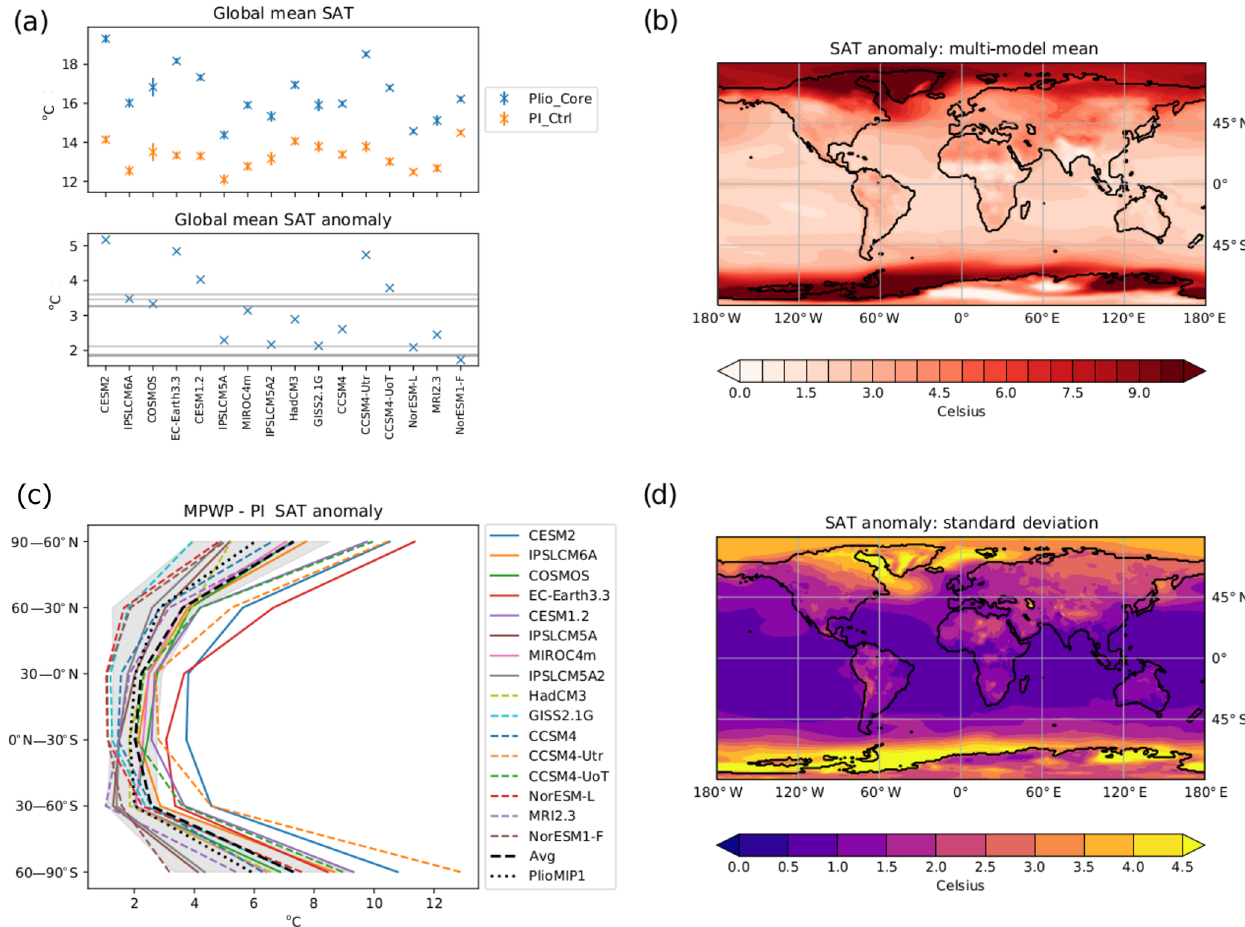
Figure 1. (a) Global mean near-surface air temperature (SAT) for the Plio Core and PI Ctrl experiments from each PlioMIP2 model (upper panel) and the difference between them (Plio Core –PI Ctrl ) (lower panel). Crosses show the mean value, while the vertical bars show the inter- annual standard deviation. Horizontal grey lines on the lower panel show the anomalies from individual PlioMIP1 models. (b) Multi-model mean Plio Core –PI Ctrl SAT anomaly. (c) Latitudinal mean Plio Core –PI Ctrl SAT anomaly from each PlioMIP2 model. The PlioMIP2 multi- model mean is shown by the dashed black line. The grey shaded area shows the range of values of the PlioMIP1 models. The PlioMIP1 multi-model mean is shown by the dotted black line. (d) Intermodel standard deviation for the Plio Core –PI Ctrl